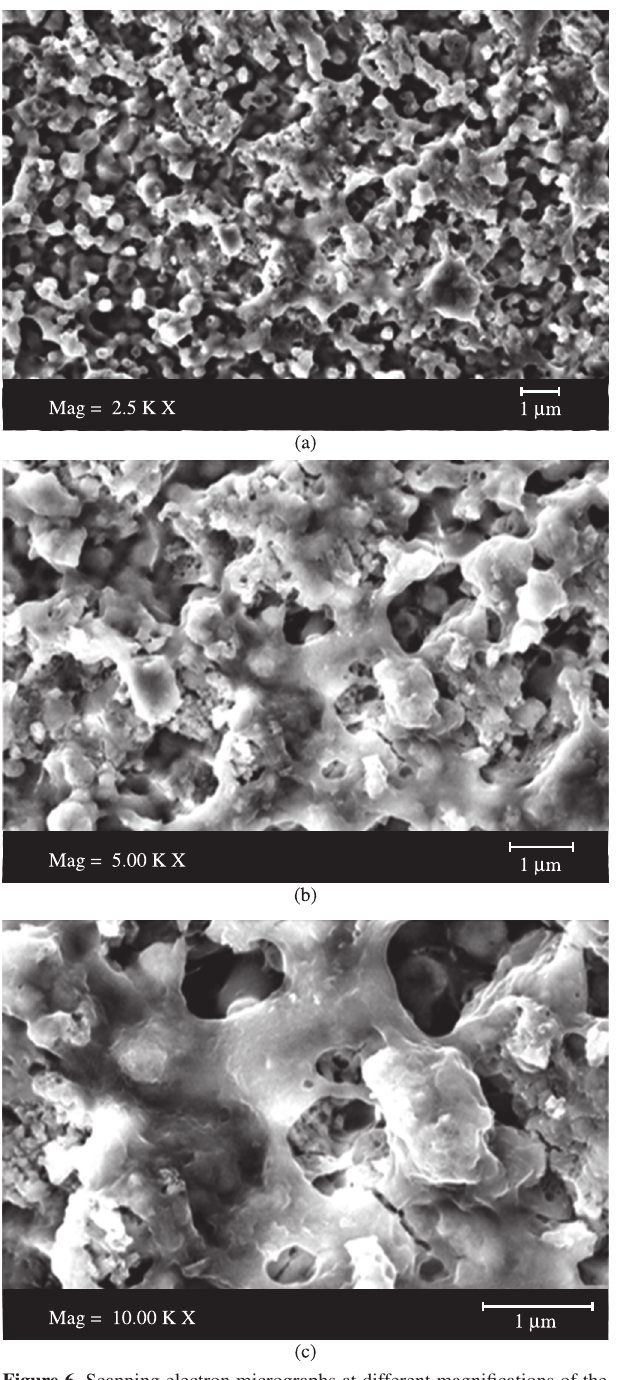
O films and (b) the compositional 2 4 O films after 2 4